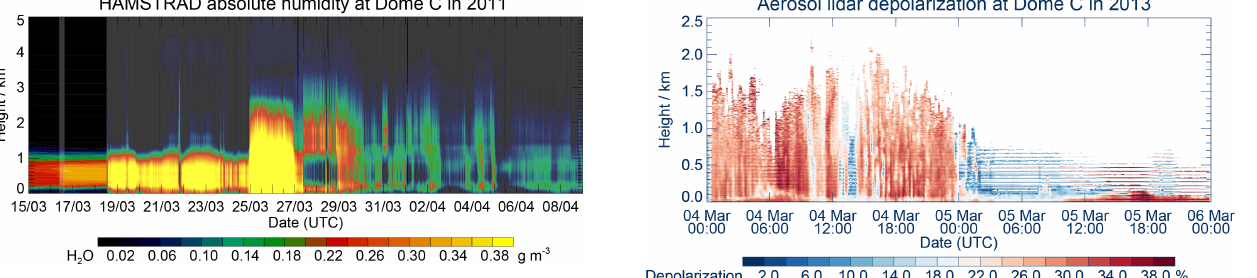
Figure 7. Time evolution of the depolarization ratio (%) from 4 to 5 March 2013 above the Dome C station as measured by the aerosol lidar installed at Dome C.